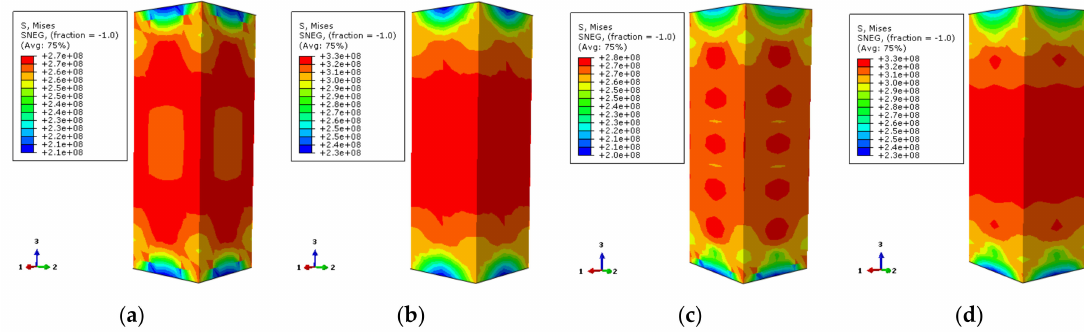
Figure 18. The Mises stress distribution of the steel tube ( a ) DS-200-0-0.75; ( b ) DS-200-0-1; ( c ) DS-200-0.75; ( d )